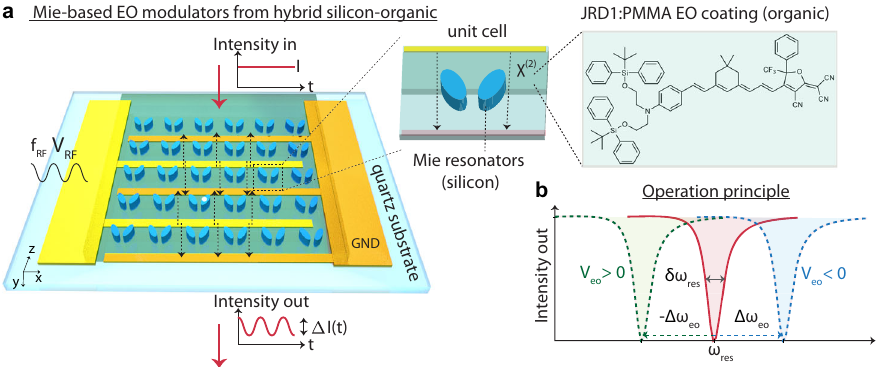
Fig. 1 Ultrathin Mie-based free-space electro-optic modulators. a Free-space electro-optic modulators change the properties of a beam that is incident from free space. Sub-wavelength Mie resonators impart an intensity modulation to the incident light that propagates through the thin fi lm via the electro- optic effect that occurs in an organic electro-optic coating that covers the nanoresonators; the interaction length is typically a few hundred nanometers long, shorter than a single wavelength, commensurate with the thickness of the organic electro-optic coating. b Resonant electro-optic modulators work on the principle that their resonant frequency ω res is tuned by Δ ω eo ( t ) linearly by an applied bias, due to the phase shift induced by the electro-optic effect. A radio-frequency bias V RF ( t ) = V eo × sin (2 π f RF t ) is applied across two interdigitated electrodes (signal is shown in yellow and GND is shown in orange) displacing the resonance frequency around its zero bias value. Narrowband resonances that satisfy Δ ω eo > δω res are preferred for full intensity modulation at low switching voltages. Dashed black arrows indicate the applied tuning fi eld that introduces the electro-optic effect. Red arrows indicate the propagating optical fi eld. EO electro-optic, GND ground.